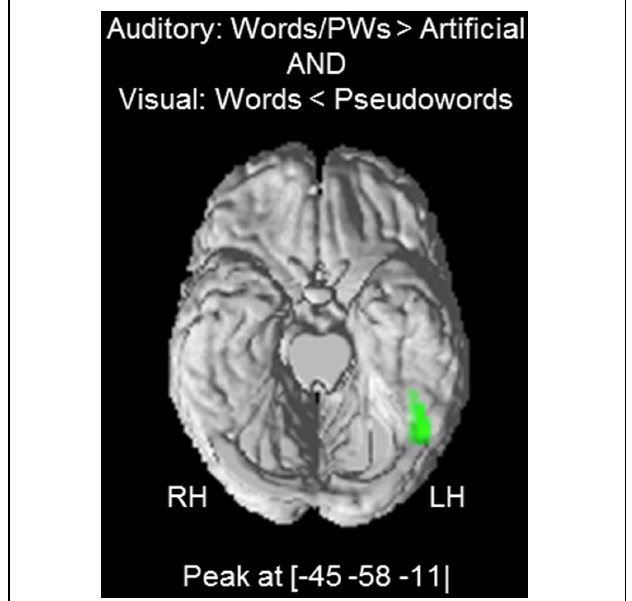
FIGURE 3 | Conjunction analysis: overlap between the auditory words/pseudowords > artificial effect and the visual words < pseudowords ( p < 0 . 001 voxel-wise threshold with a cluster extent threshold of p < 0 . 05, FWE corrected). The activation cluster is superimposed on the ventral surface of a standard brain